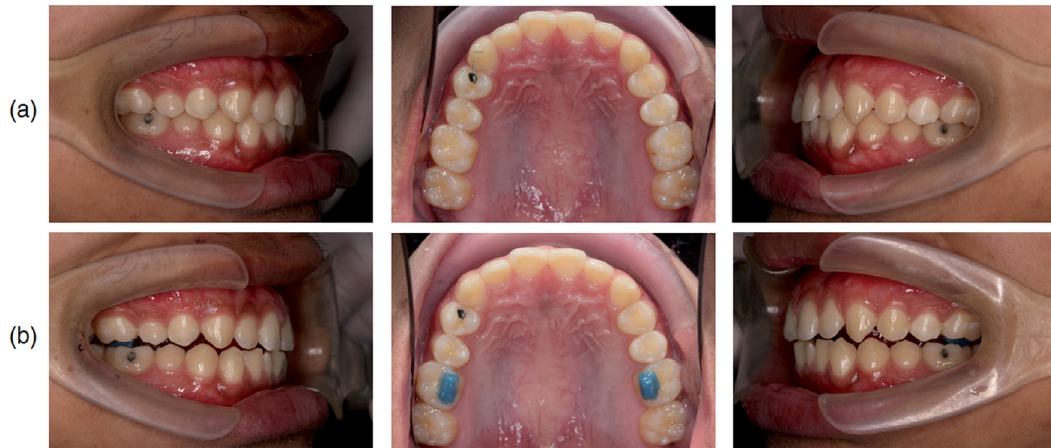
Figure 1- Intraoral photos (a) before and (b) after temporary bite-raising with light-cured orthodontic band